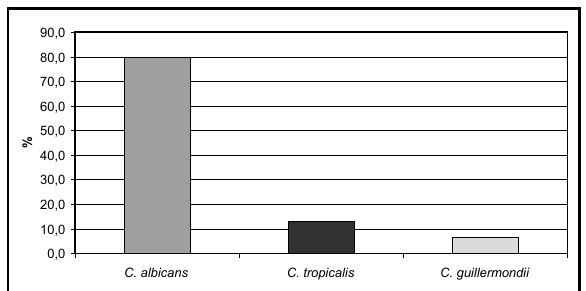
Figura 1 – Freqüência de espécies isoladas do gênero Candida spp. de amostras da mucosa oral dos pacientes diabéticos do Ambulatório de Endocrinologia do HUWC/UFC